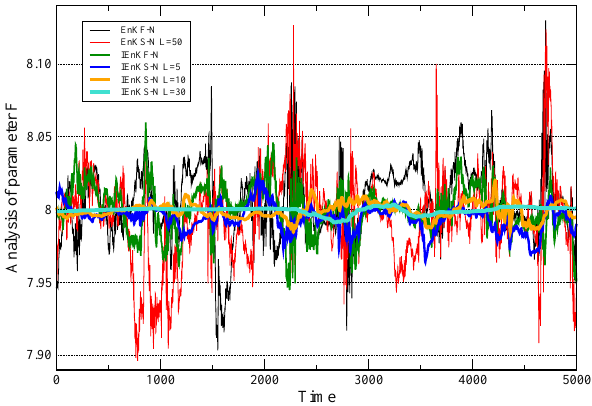
Fig. 6. Root mean square errors for the analysis of the state vector at present time (filtering) or the retrospective analysis of the state vector (smoothing) for the EnKF, EnKS and the IEnKS, in the case of the Lorenz ’95 model, with ∆ t = 0 . 05 .